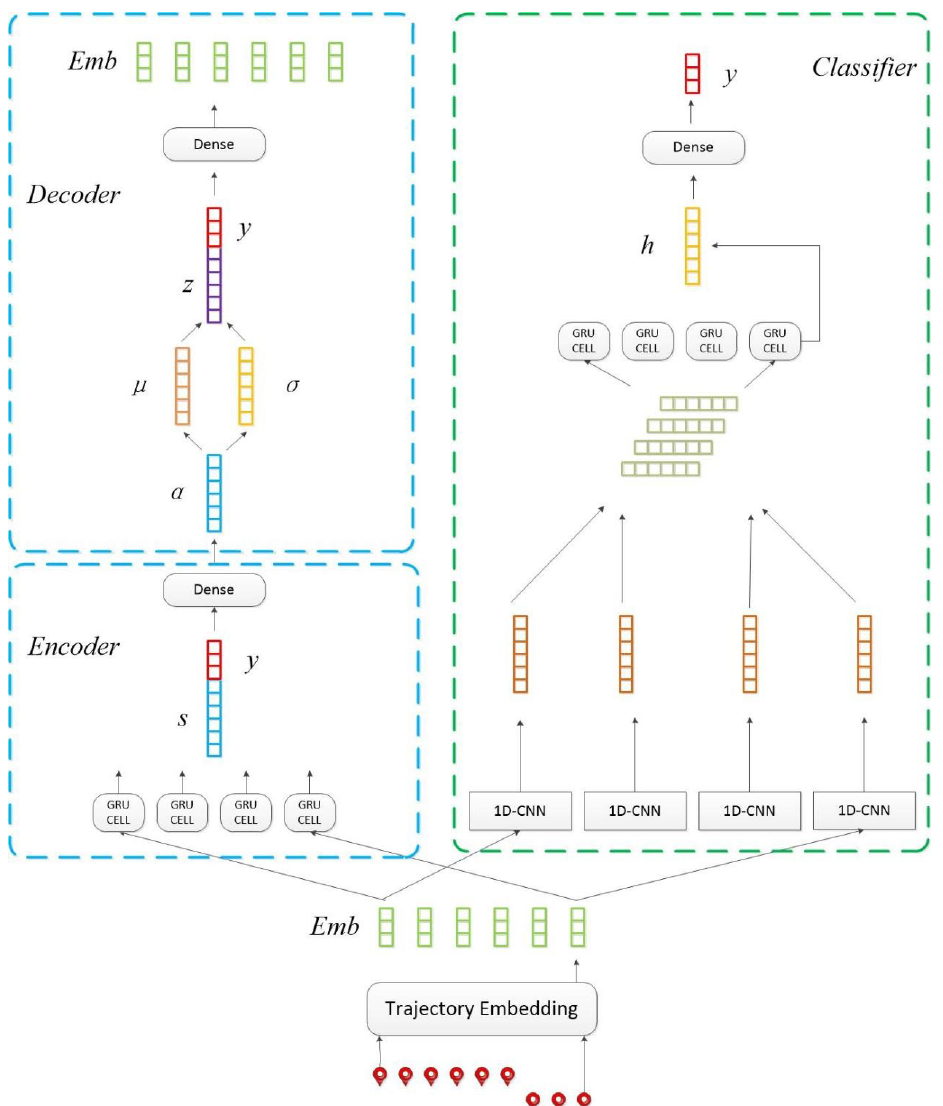
Figure 2. The GeoSDVA